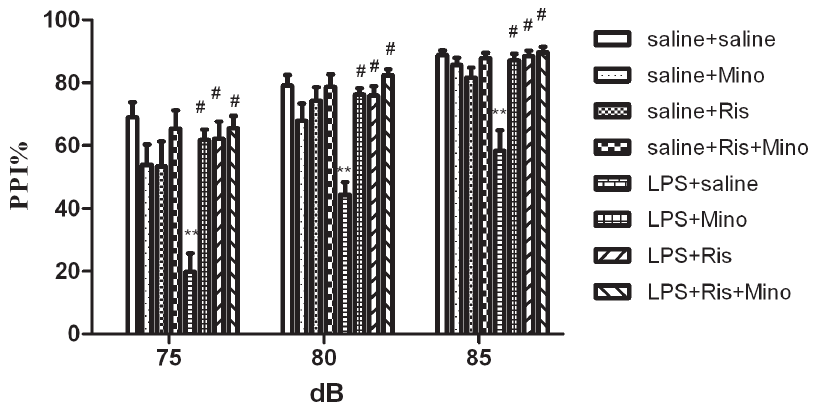
Figure 5. Effects of minocycline,risperidone, minocycline combination with risperidone on LPS-induced PPI deficits in rats. The data is shown as means 6 SEM. n=8 for each group. ** P , 0.01. compared with saline-injected group; # P , 0.01,compared with LPS-injected group.